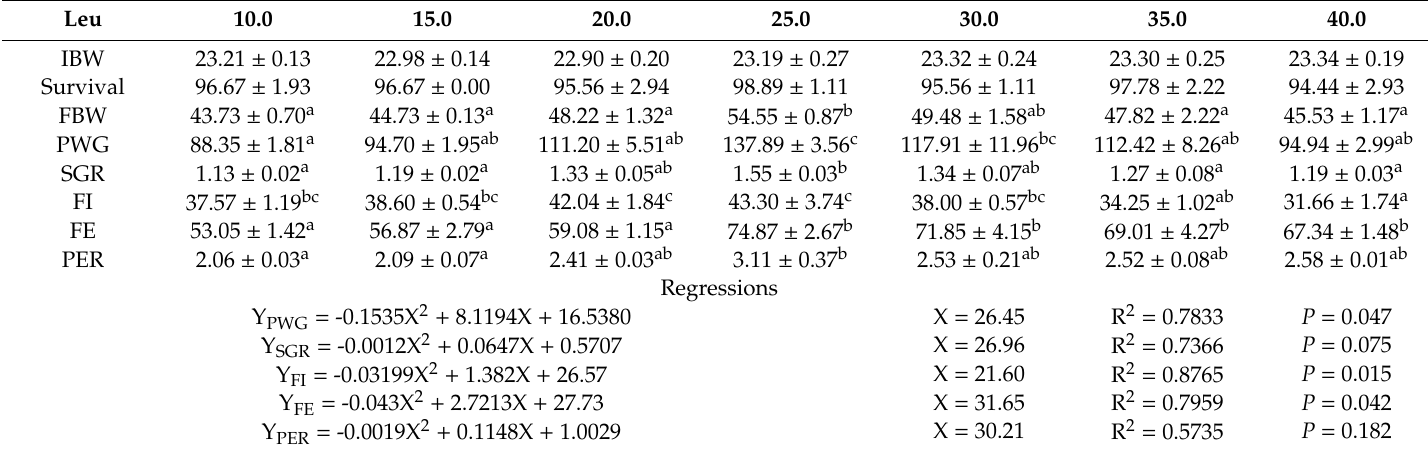
Table 4. Initial body weight (IBW, g fish -1 ), survival, final body weight (FBW, g fish -1 ), percent weight gain (PWG, %), specific growth rate (SGR, % / d), feed intake (FI, g fish -1 ), feed e ffi ciency (FE, %), and protein e ffi ciency ratio (PER) of hybrid catfish fed diets containing graded levels of Leu (g kg -1 ) for 8